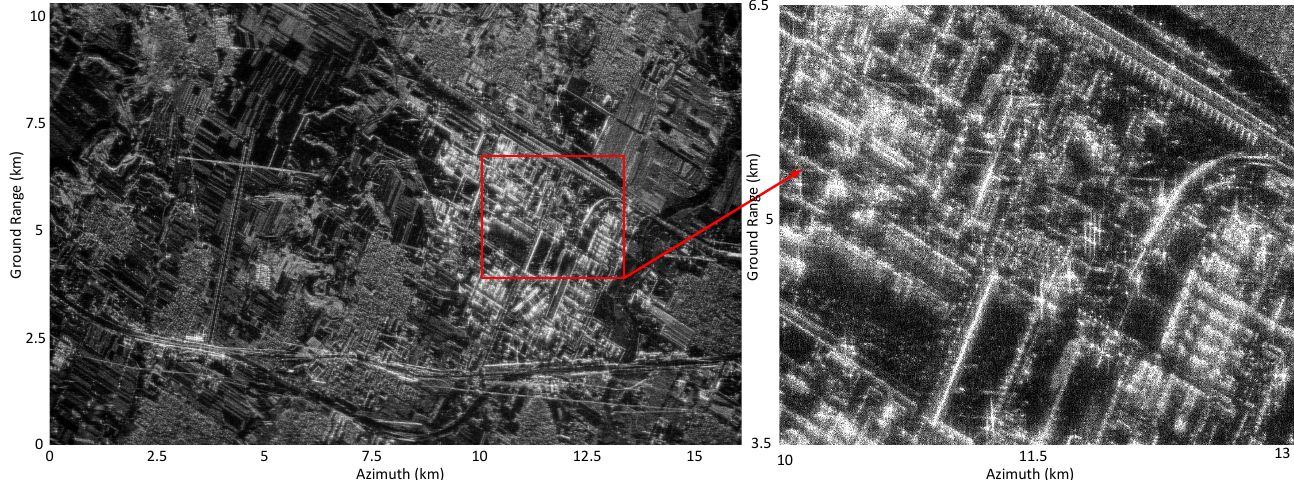
Figure 10. The compensated SAR image for the HH